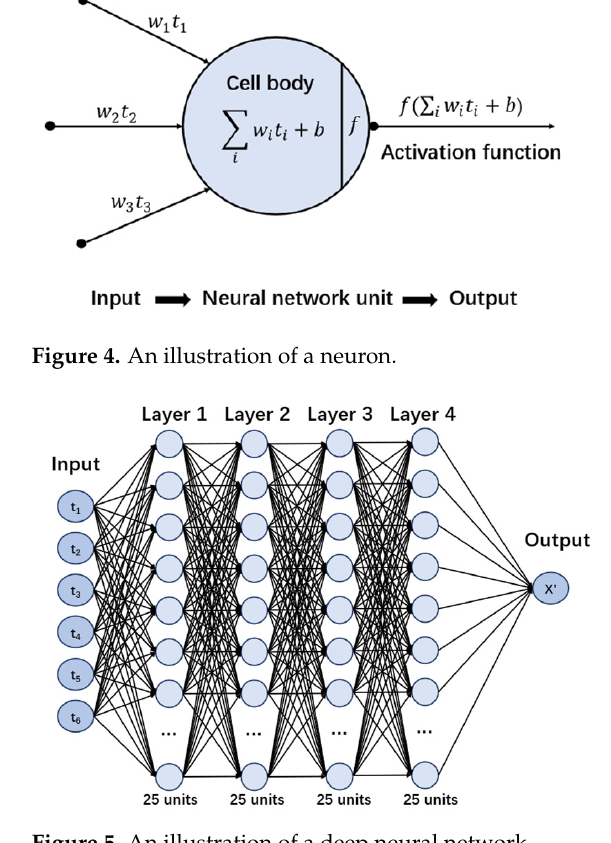
Figure 5. An illustration of a deep neural network.